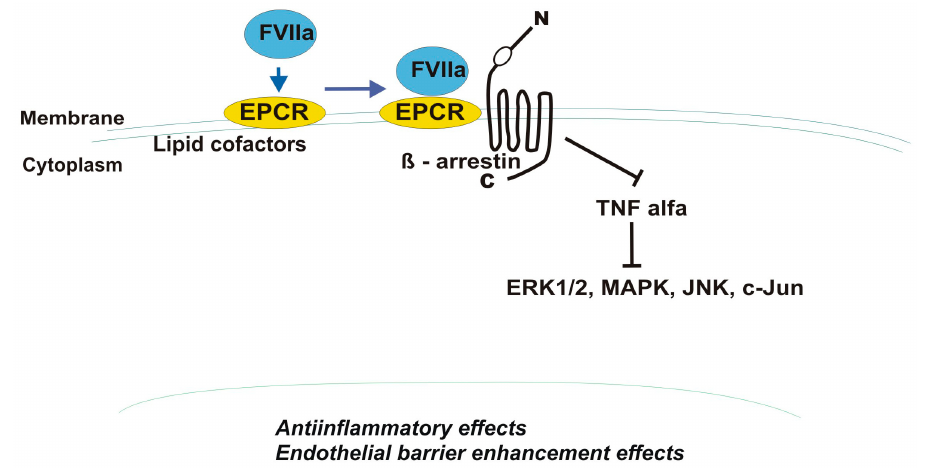
Figure 3. Factor VIIa—mediated activation of endothelial protein C receptor (EPCR) and protease-activated receptor 1 (PAR-1) leading to suppression of tumor necrosis factor alfa (TNF- α )—dependent signaling. ERK—extracellular signal-regulated kinase; MAPK—mitogen activated protein kinase, c-Jun, JNK—N-terminal